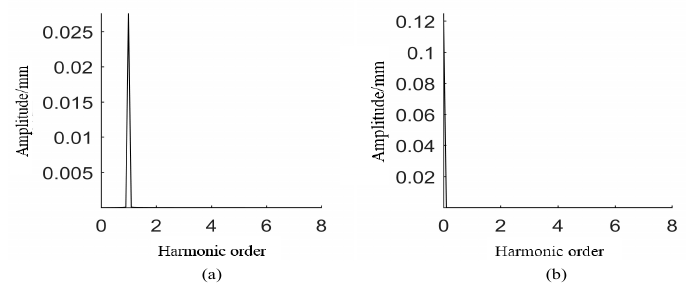
Figure 5. Vibration response spectrum diagram under normal conditions: ( a ) Horizontal vibration; ( b ) Torsional vibration.